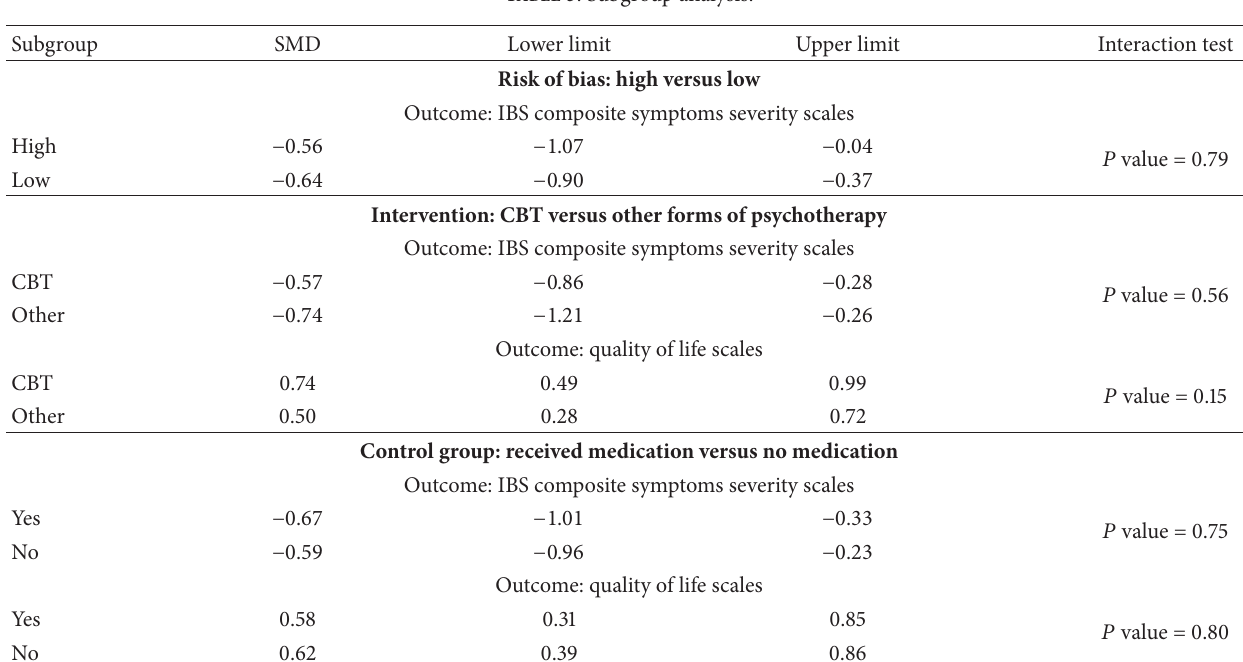
Table 3: Subgroup